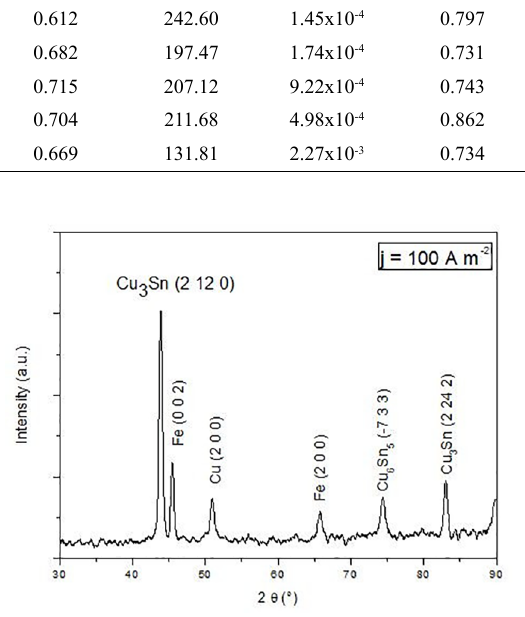
Figure 7. XRD analysis for Cu-Sn coating produced using j = 100 A m -2 .